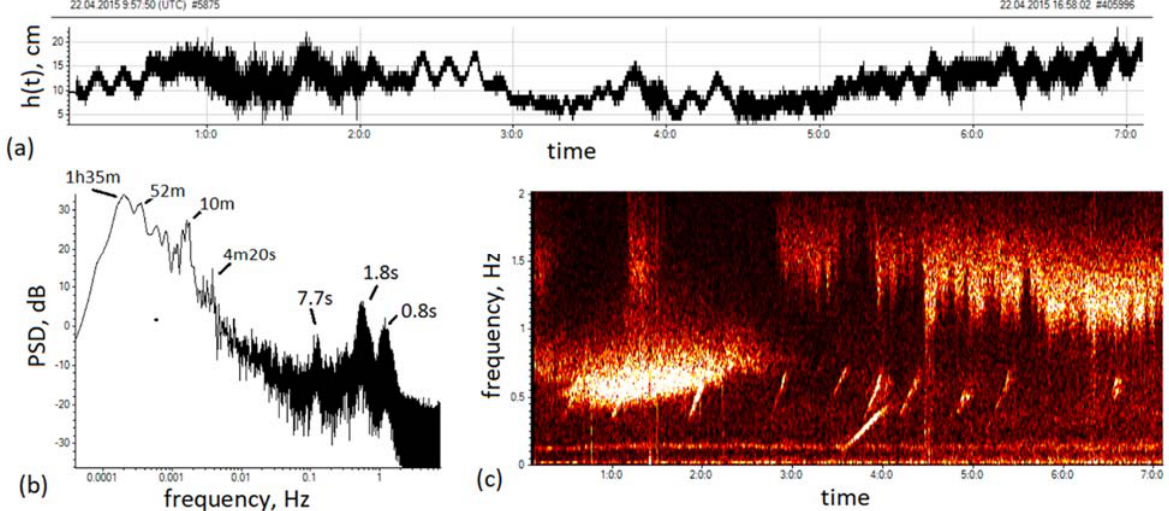
Figure 18. Analysis of the 7 h recording of the wave signal (22 April 2015, 09:57–16:58): ( a ) waveform, ( b ) spectrum, ( c )